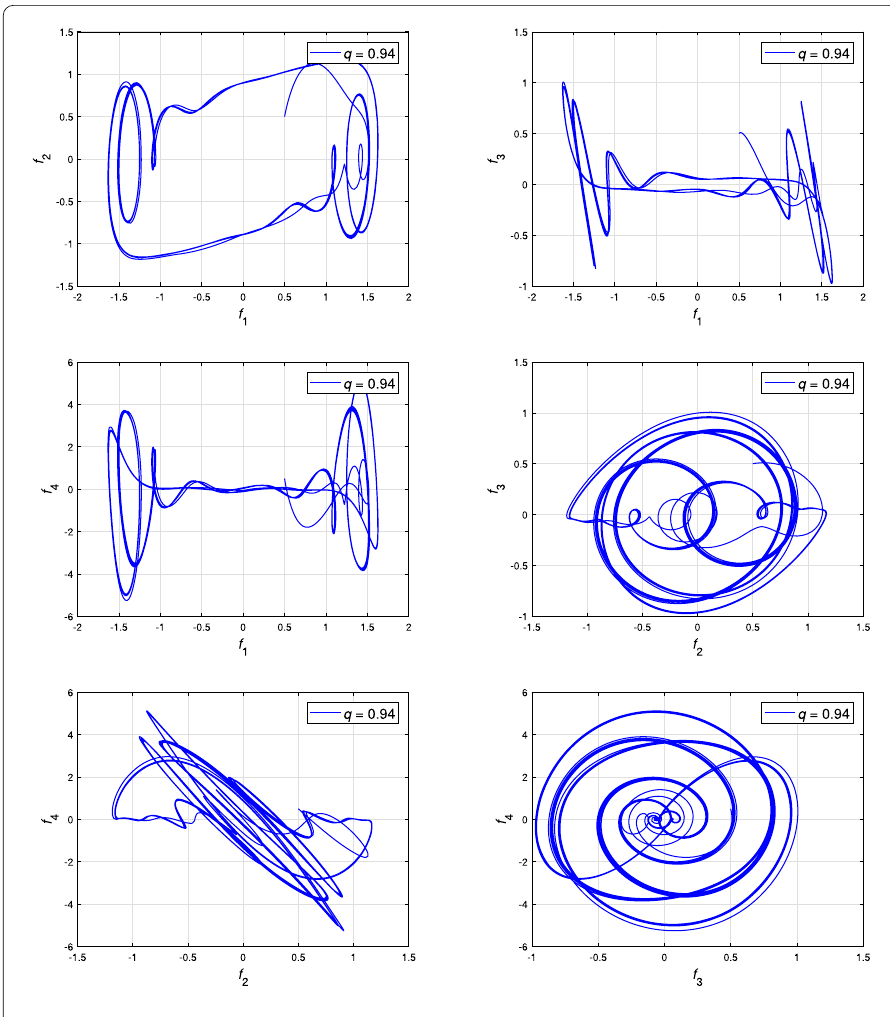
Figure 3 The phase planes of the fractional chaotic system (6) for q = 0.94